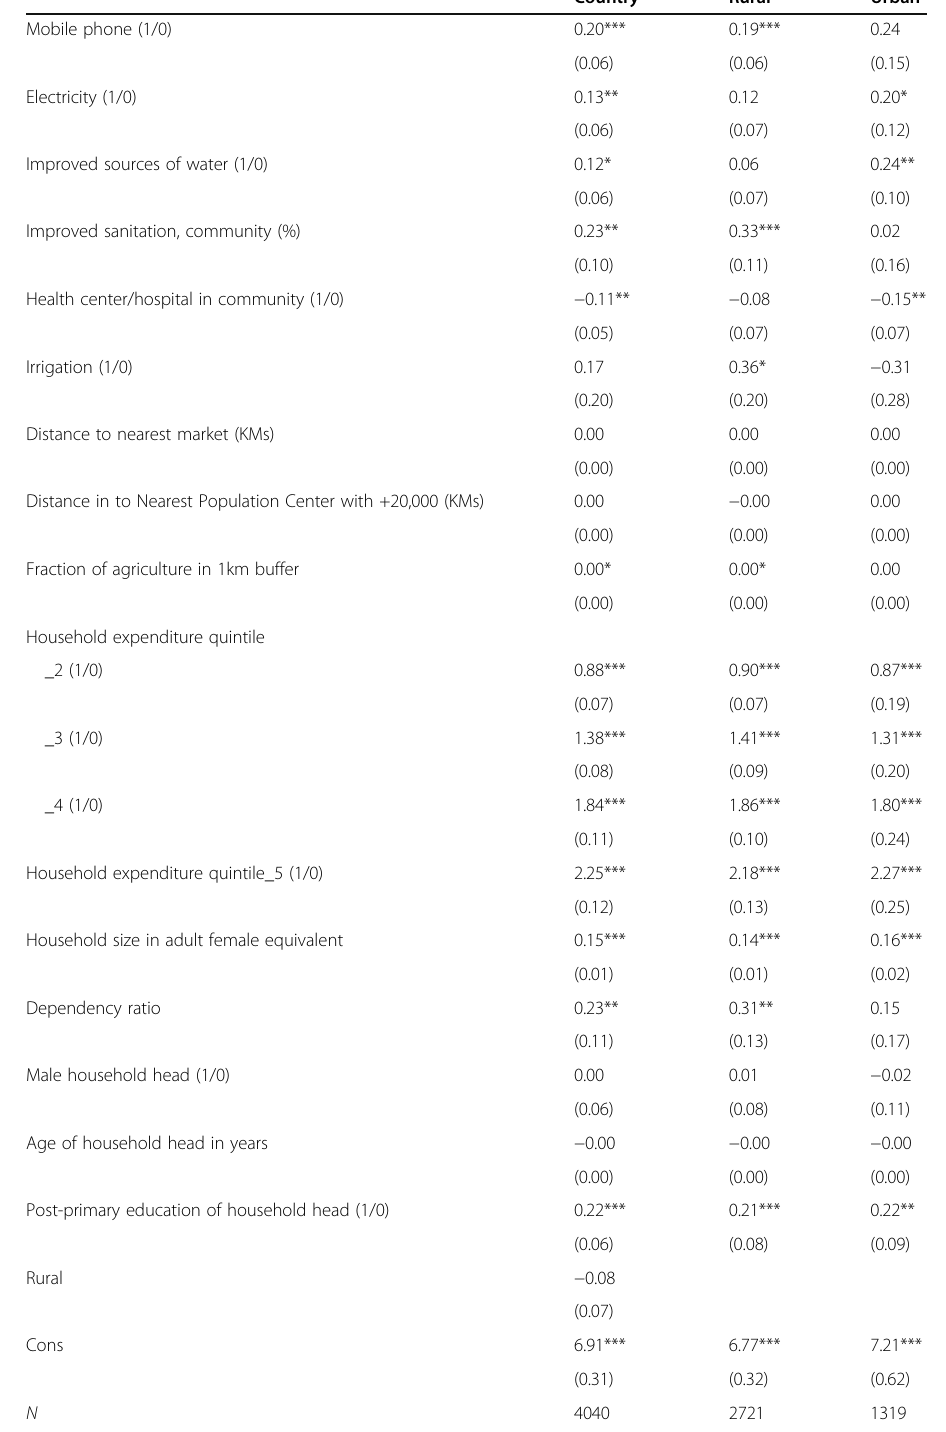
Table 4 Correlates of household dietary diversity